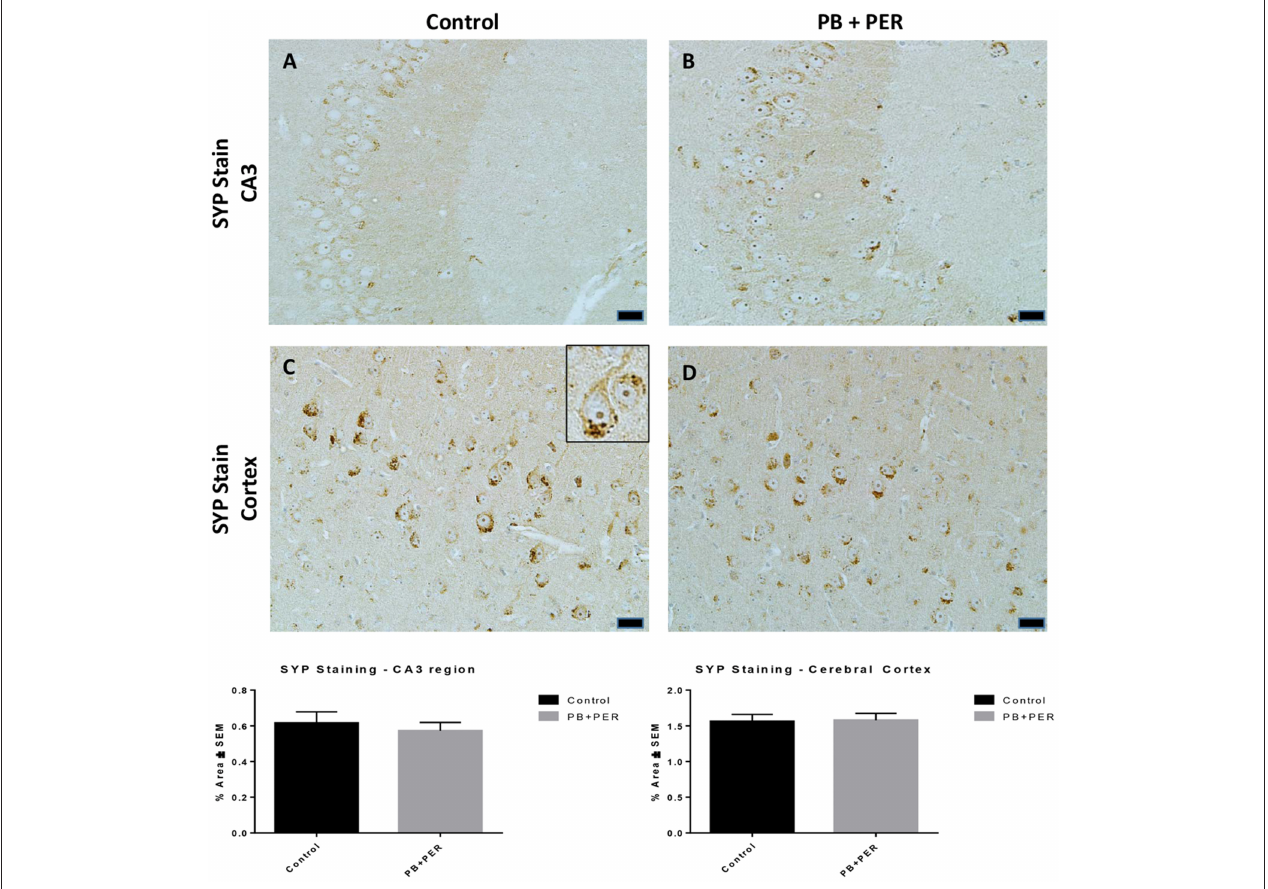
FIGURE 11 | No differences were observed in SYP staining in cerebral cortices and the CA3 regions of exposed mice, ∼ 22.5 months post-exposure. No differences were observed in SYP staining in the CA3 region of exposed mice (B) vs. controls (A) . No differences were observed in SYP staining in the cerebral cortices of exposed mice (D) vs. controls (C) (Student t -test, p = 0.84 ). Representative images were taken at 40X magnification (scale bars represent 20 µ m). Inset depicts positive SYP staining showing dark brown pre-synaptic vesicles stained within the cell soma (see inset in C ). Histograms depict the quantification of the SYP stain in the hippocampi and cerebral cortices, as % Area per microscopic